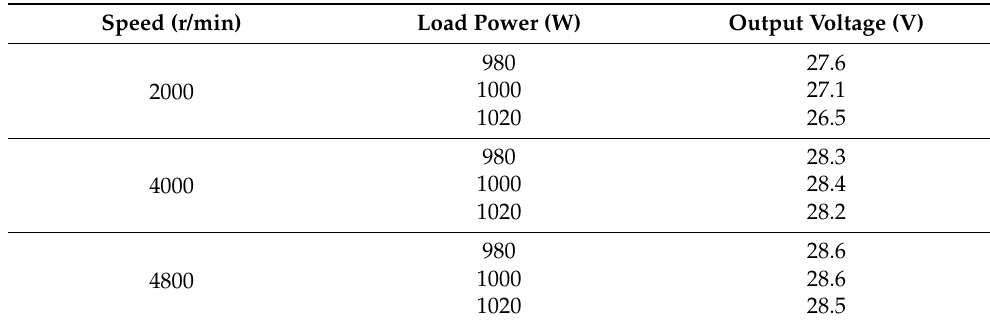
Table 7. Compound excitation generator output performance experimental